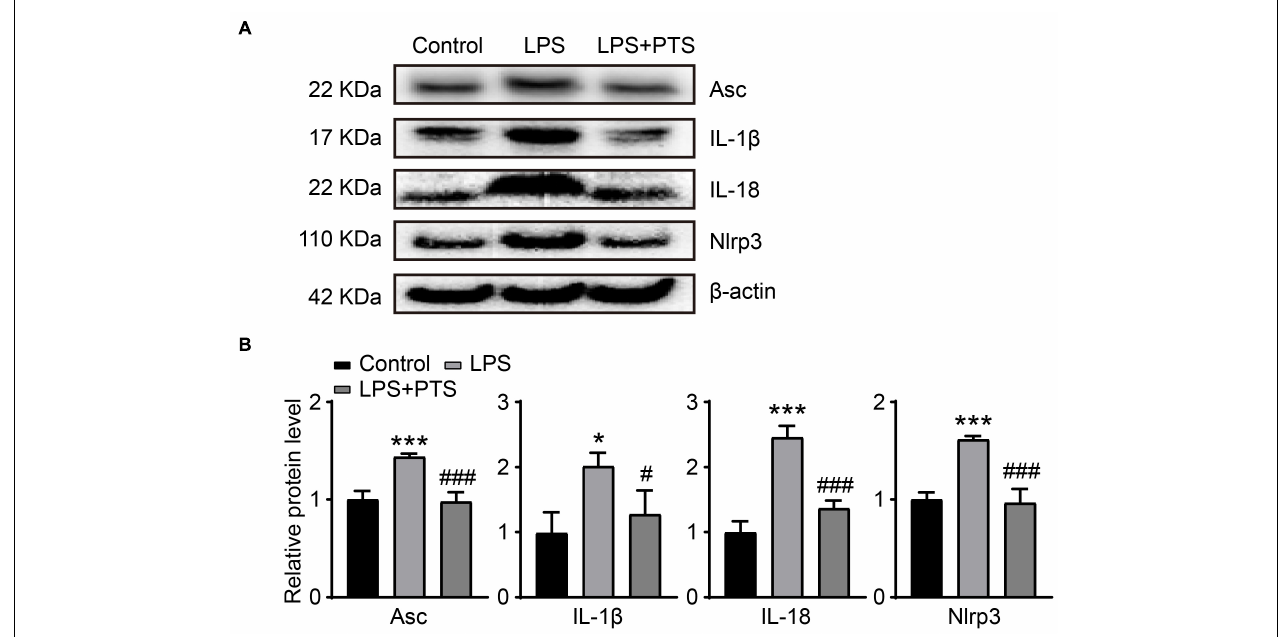
FIGURE 6 | PTS inhibits Inflammasome-related pathways in LPS-Induced H9C2 cells. (A) Expressions of ACS, IL-1 β , Il-18, NLRP3 and β -actin protein in heart tissue were measured by Western blotting analysis. (B) Relative quantitative analysis of ACS, IL-1 β , Il-18, and NLRP3 ( n = 3). * P < 0.05, *** P < 0.001 control vs. LPS, # P < 0.05, ### P < 0.001 LPS vs. LPS +